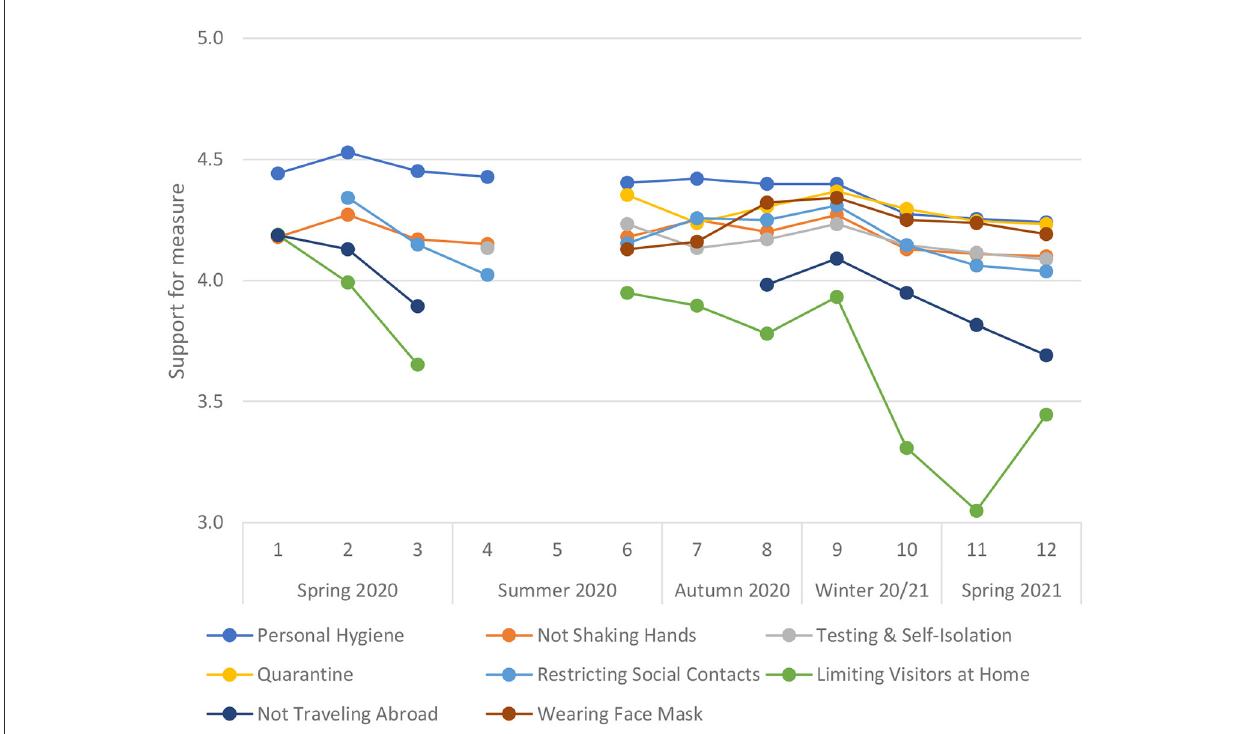
FIGURE1 Support for COVID-19 mitigation measures over time. Wave 1: April 2020. Wave 12: May 2021; N = 54,010 participants who responded to support items; analyses of trends corrected for participant demographic characteristics.